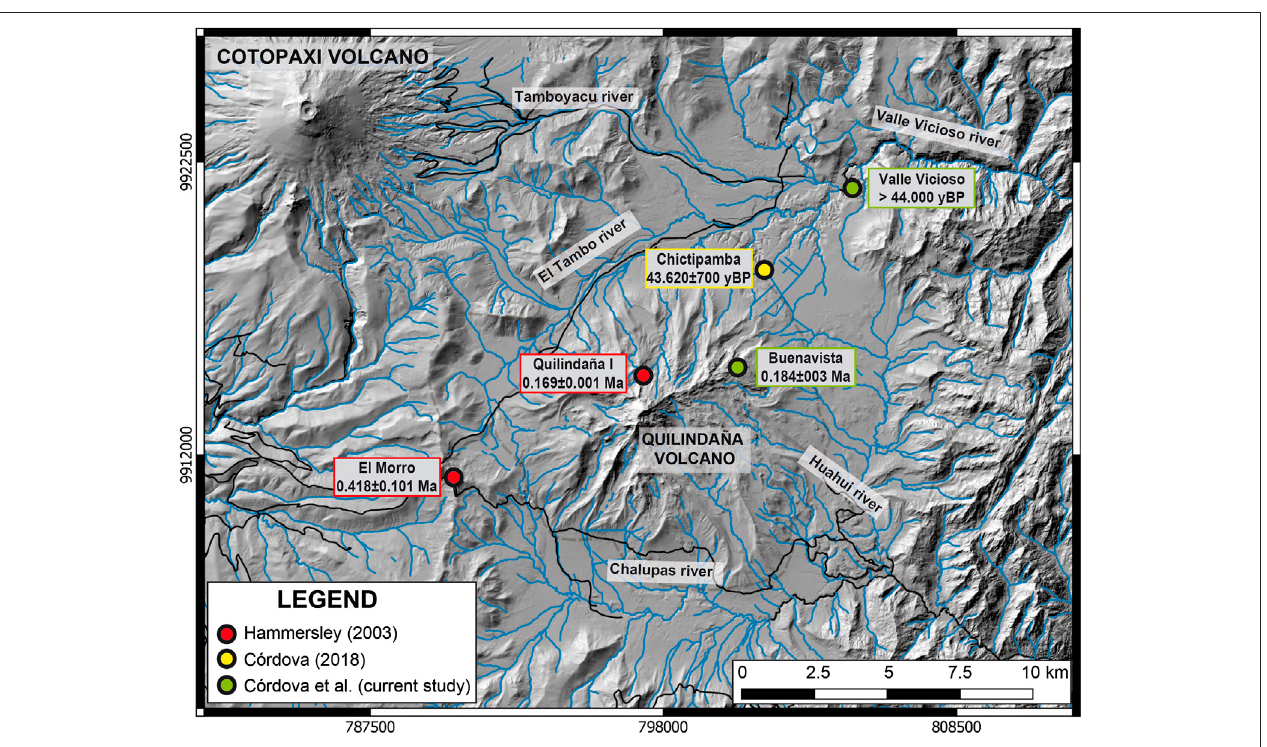
FIGURE 5 | Distribution of the radiometric ages from Hammersley (2003) (red circles), Córdova (2018) (yellow circle) and (current study) (green circle).